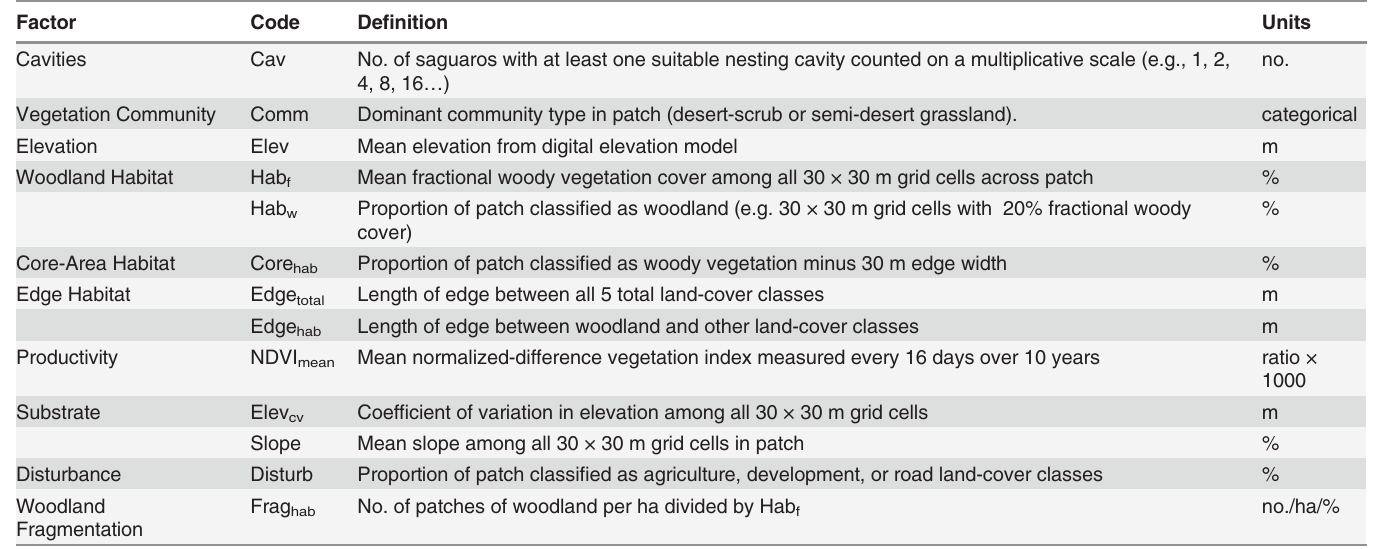
Table 1. Factors considered when modeling the effects of habitat resources on reproductive output of ferruginous pygmy-owls in northwest Mexico, 2001 –